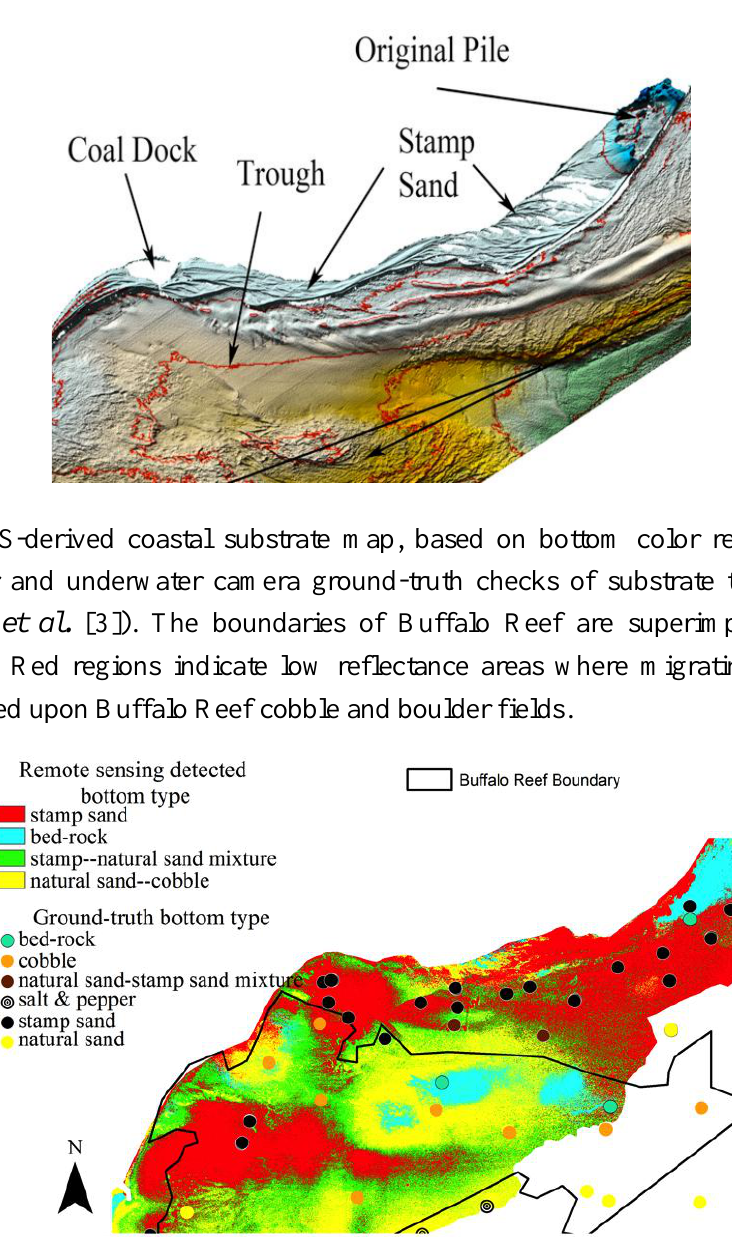
Figure 8. Enlargement of the 2010 LiDAR-derived mosaic documents stamp sands moving into the northern cobble/boulder fields of Buffalo Reef. Migrating stamp sand bars pour into the “trough”, mounding up in the northern reaches of the trough before progressing northwestward onto Buffalo Reef. Red contour intervals are spaced at 5 m.